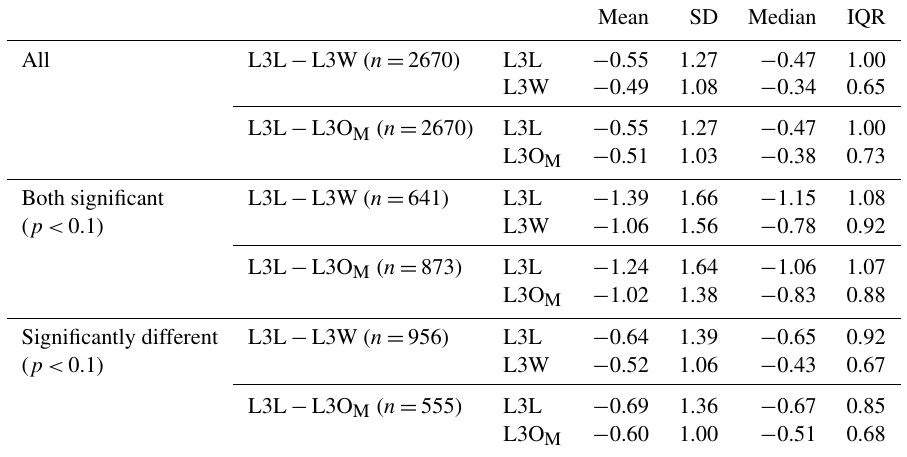
Table 3. Descriptive stats corresponding to the WLS trends detected in L3L, L3W, and L3O M that are compared in the boxplots of Fig. 5c. SD denotes standard deviation; IQR denotes interquartile range. Mean SD All L3L − L3W ( n =